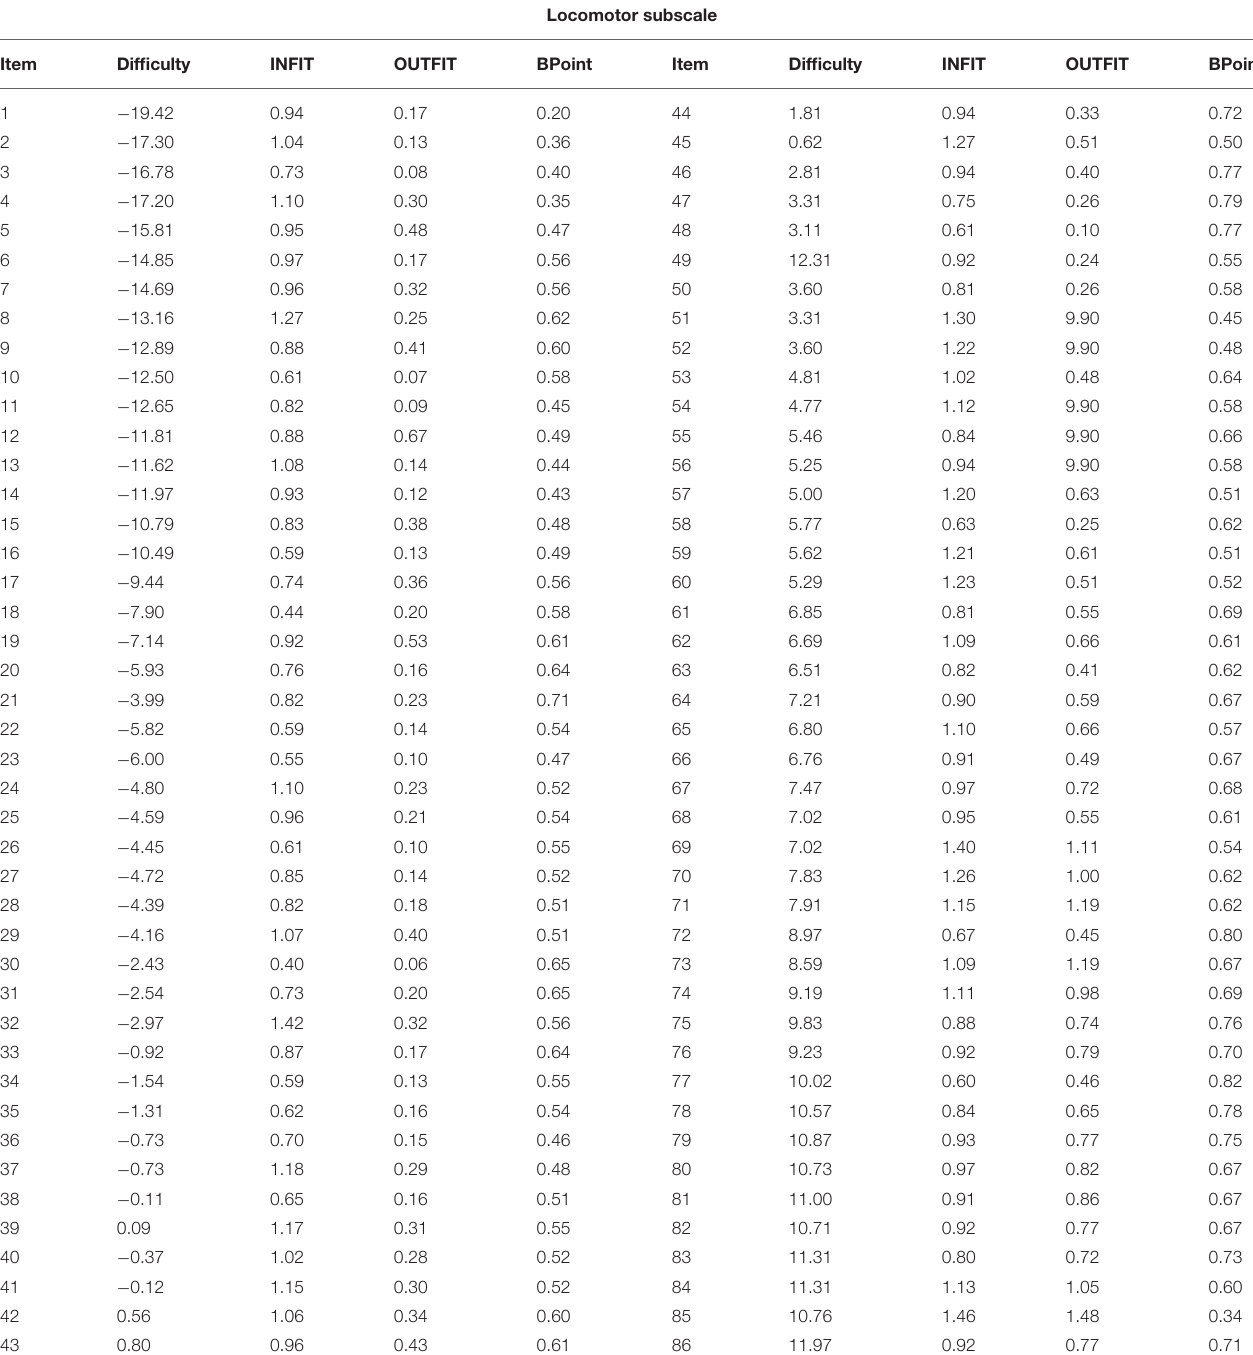
TABLE 4 | Locomotor subscale: item difficulty, INFIT, OUTFIT, and point-biserial correlations for all items (no item was